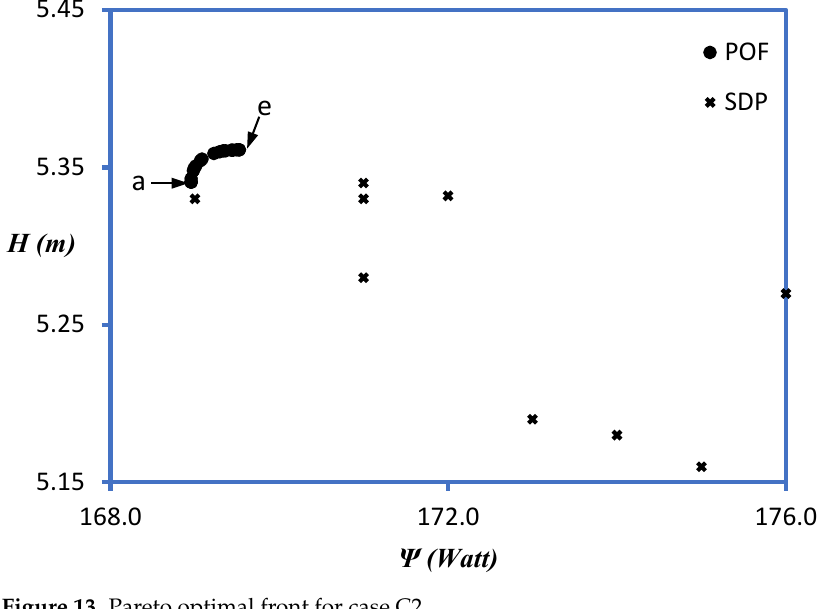
Figure 13. Pareto optimal front for case C2.